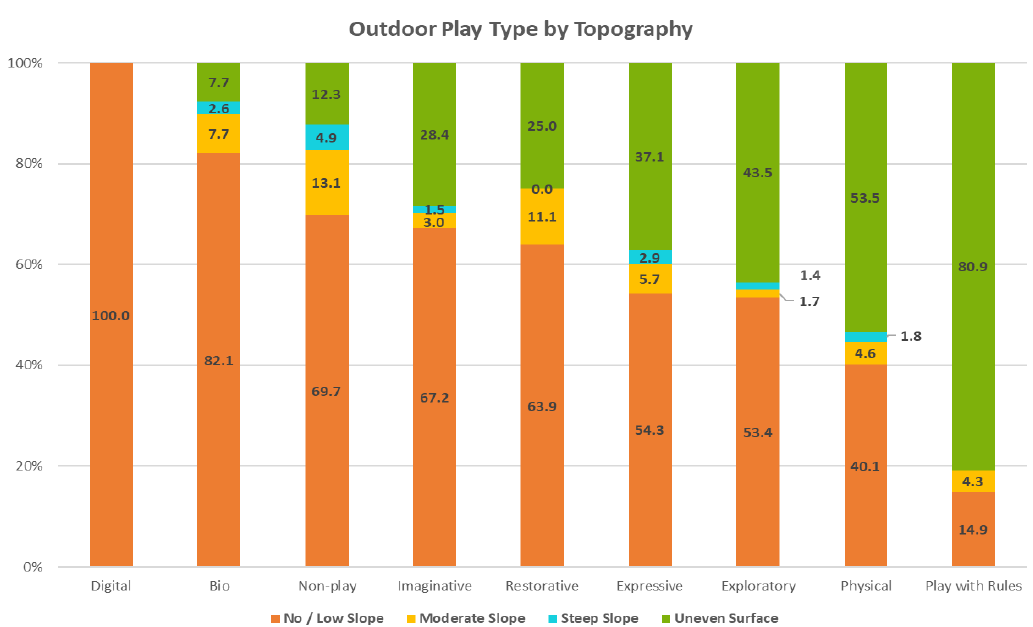
Figure 13. Outdoor play types by topography.